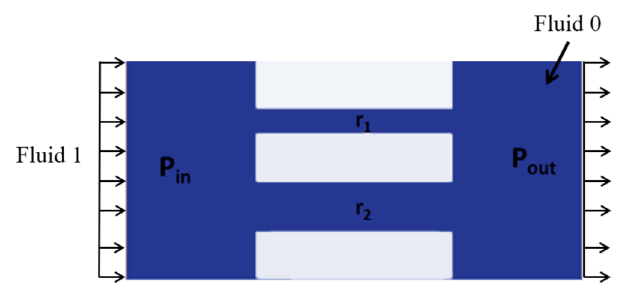
Figure 2. Initial setup for the capillary pressure test.